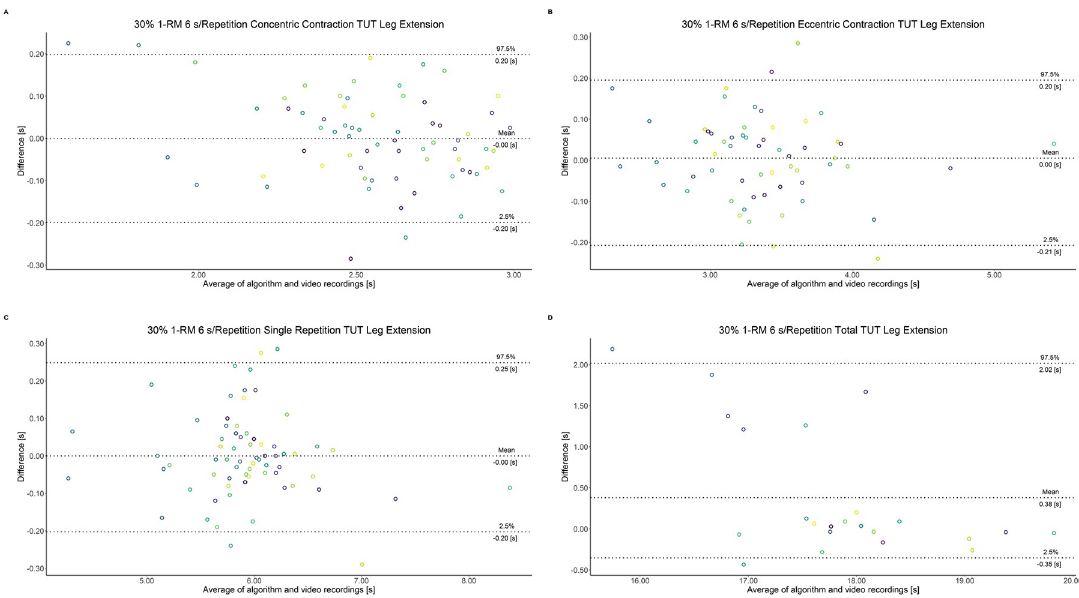
Fig 5. Bland-Altman plots of agreement between algorithmically accelerometer derived and video recordings derived contraction- specific phases of the leg extension machine at 30% 1-RM with a velocity of 6 s per repetition. A: Concentric contraction phase. B: Eccentric contraction phase. C: Single repetition. D: Total time-under-tension.